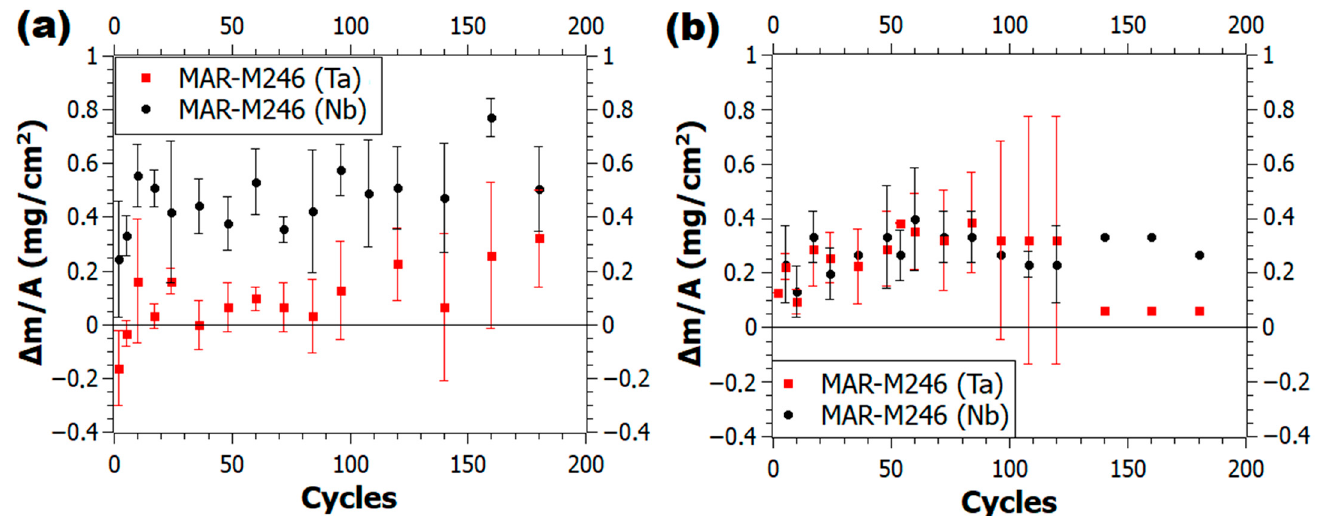
Figure 1. Comparison between the mass variation per unit area. ( a ) 900 °C, ( b ) 1000 °C.